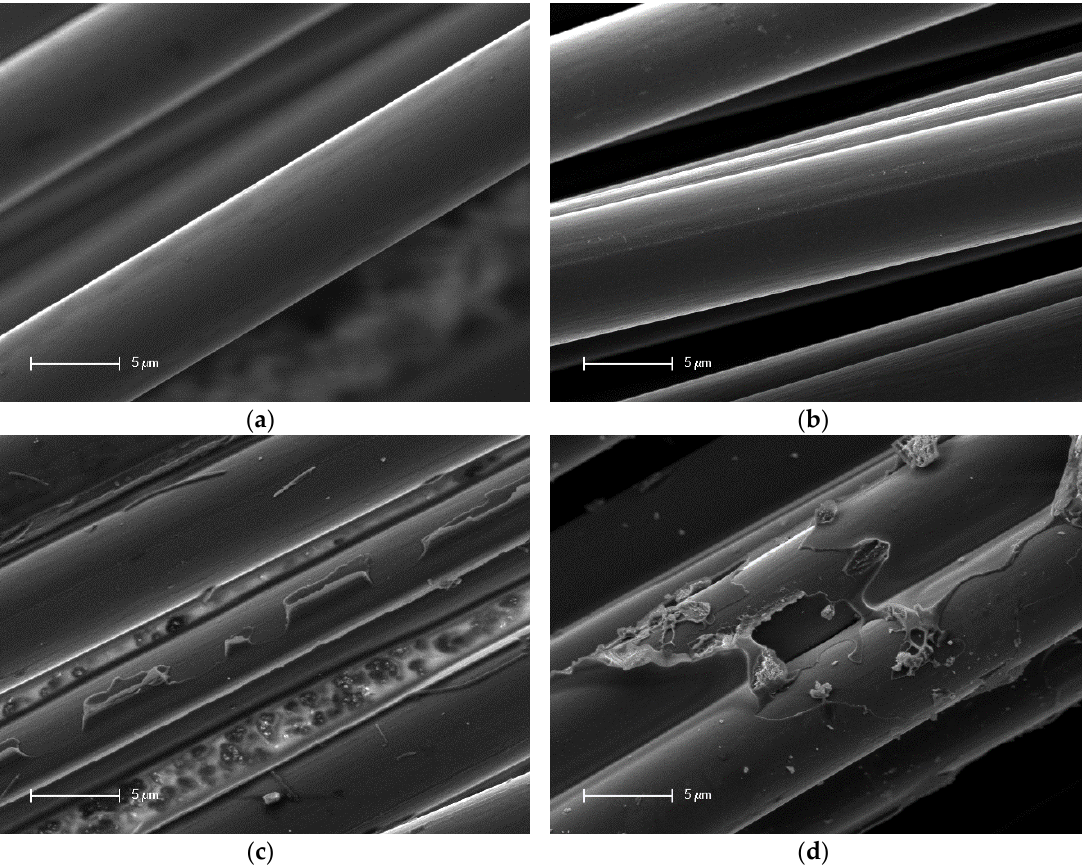
Figure 4. Scanning electron microscopy (SEM) images of the filaments: ( a ) reference, ( b ) reference without the sizing agent, ( c ) detached and treated with 66% power, and ( d ) detached and treated with 96% power.